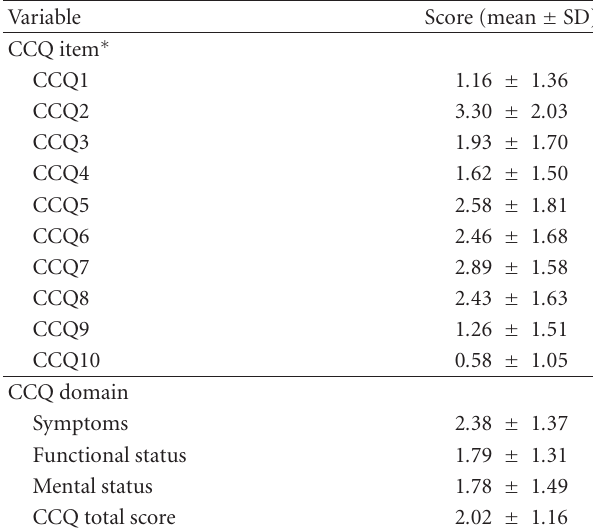
Figure 1: Box plot for CCQ scores by GOLD classification (FEV1 % predicted). Error bars show standard deviation and horizontal lines within boxes show the mean for CCQ